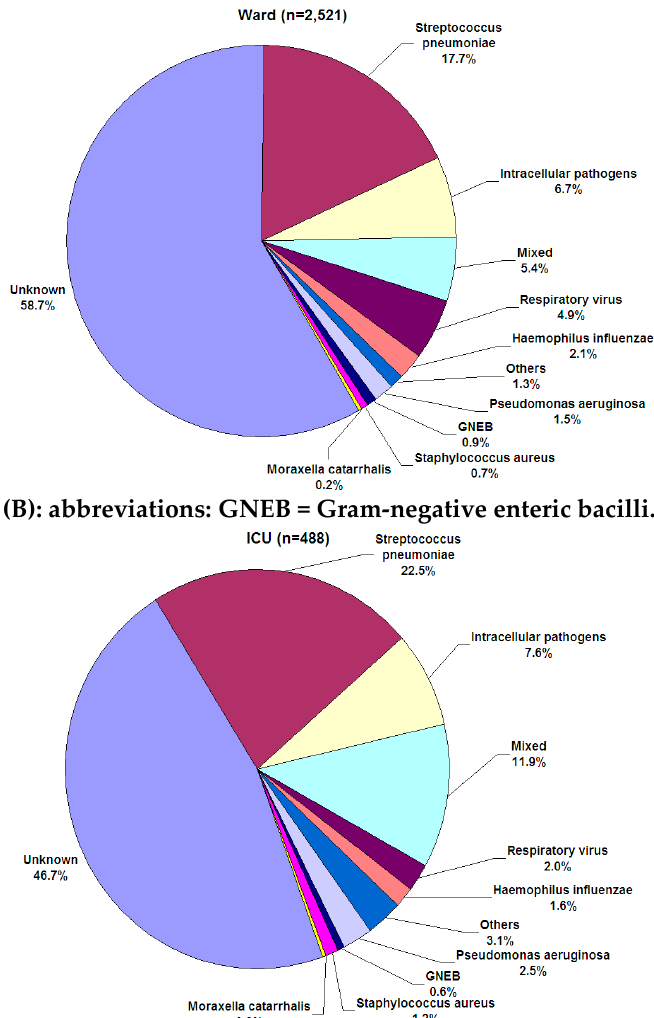
(C): abbreviations: ICU = intensive care unit; GNEB = Gram-negative enteric bacilli. Figure 1. The most commonly identified pathogens among adults with Community-acquired pneumonia in Spain [8]. ( A ) Outpatients; ( B ) Patients Admitted to Ward; ( C ) Patients Admitted to Intensive Care Unit.